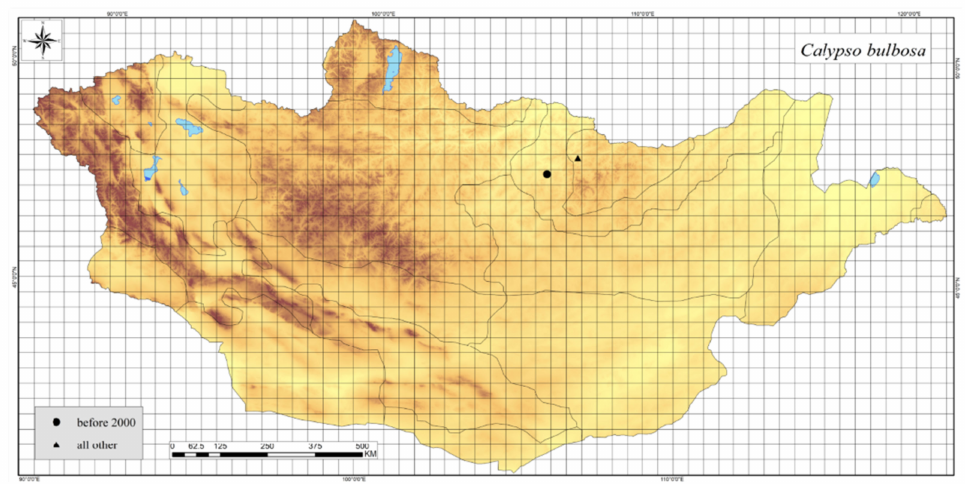
Figure A1. Distribution map of Calypso bulbosa in Mongolia.